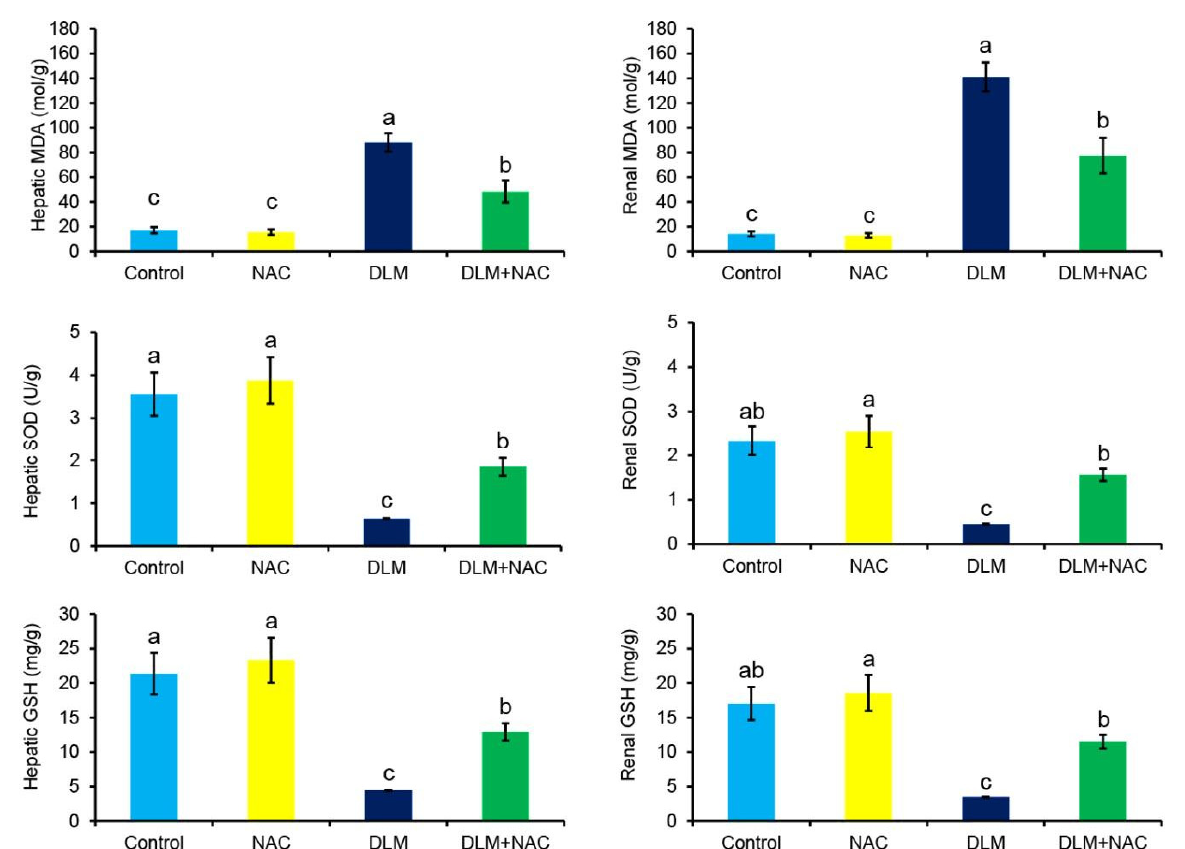
Figure 3. Effect of DLM and/or NAC treatments on hepatic and renal oxidative indexes. The values are expressed using the mean ± SE ( n = 3). The statistically significant difference ( p ≤ 0.05) is indicated by different superscript characters.